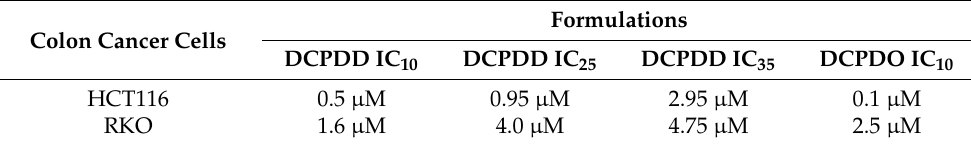
Table 2. The selected doses of DCPDD and DCPDO for cellular assays. Colon Cancer